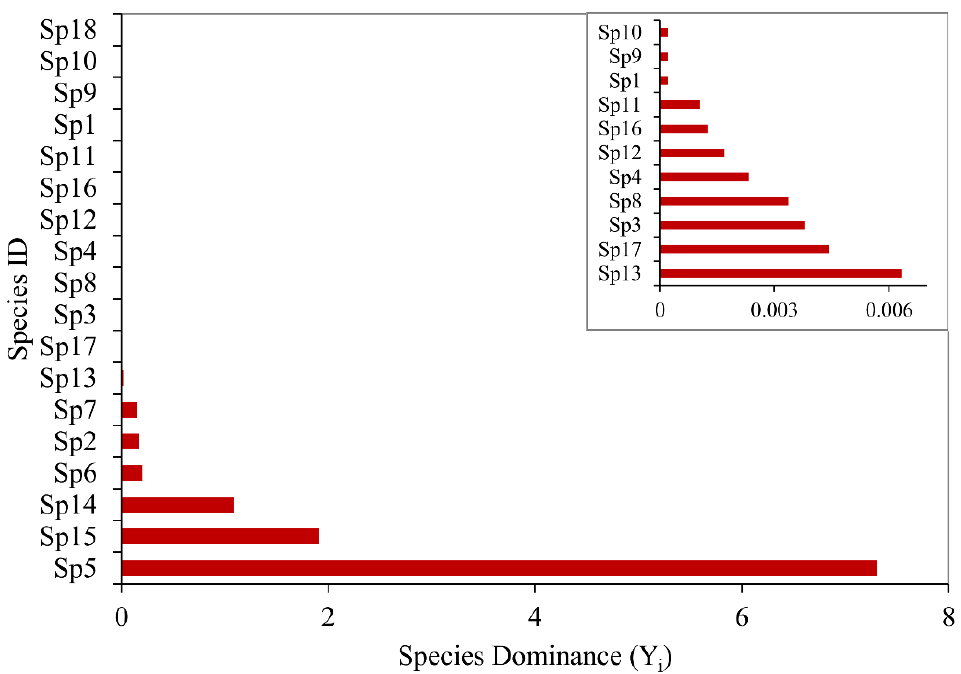
Figure 4. Species dominance of the species observed in the sampled plots. The species dominance was measured using the dominance index, where Sp1 = Aloe maculate , Sp2 = Asparagus spp., Sp3 = Dracaena trifasciata , Sp4 = Ehretia rigida , Sp5 = Eragrostis spp., Sp6 = Leonotis ocymifolia , Sp7 = Trifolium repens , Sp8 = Grewia flava , Sp9 = Leucas martinicensis , Sp10 = Lipia javani , Sp11 = Meitinas Polyacantha , Sp12 = Olea spp., Sp13 = Opuntia ficas indica , Sp14 = Scorzonera humilis , Sp15 = Senegalia nigrescens , Sp16 = Ledebouria marginata , Sp17 = Kalanchoe spp., and Sp18 = Ziziphus mucronata.